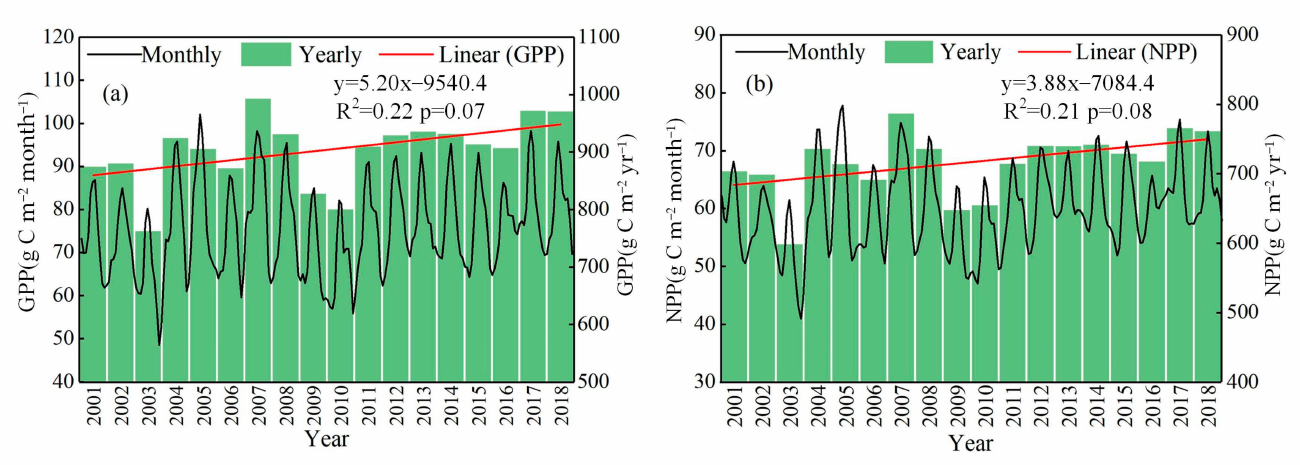
Figure 5. Monthly and annual variation trends of bamboo forests’ ( a ) GPP and ( b ) NPP in China from 2001 to